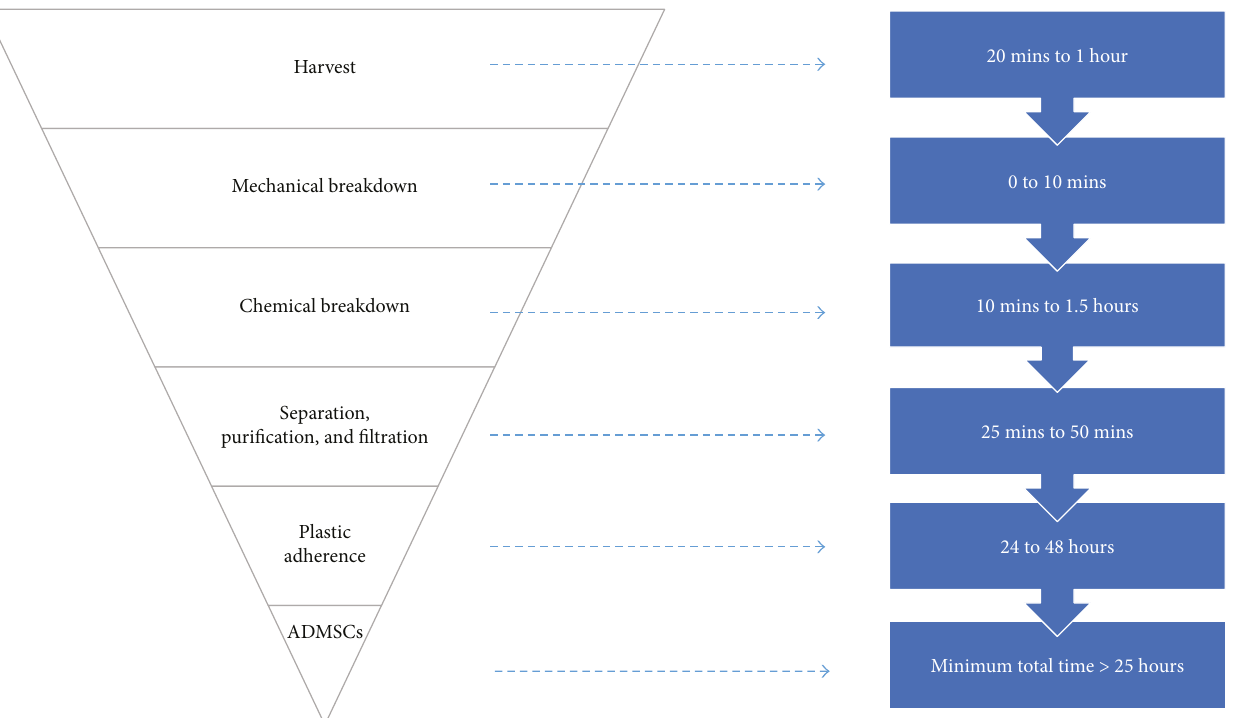
Figure 2: Adipose-derived mesenchymal stem cell (ADMSC) isolation protocol including